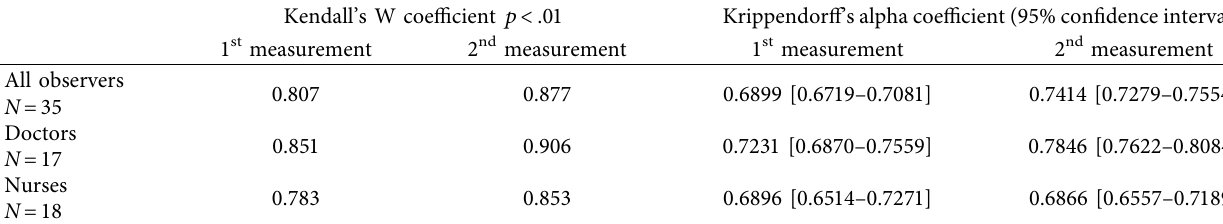
Table 4: COMFORT-B scale total score: interrater reliability.